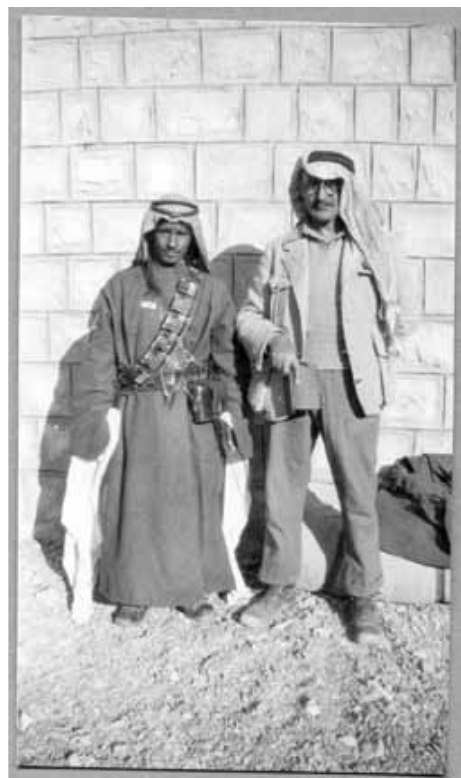
Fig. 1: George Horsfield and an unknown man at Bayir Fort,